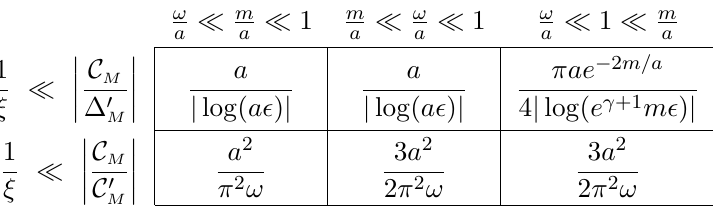
Table 3 . The Markovian conditions expressed as constraints on the relaxation time-scales (cid:24) . We only quote these constraints in the allowed ! (cid:29) a